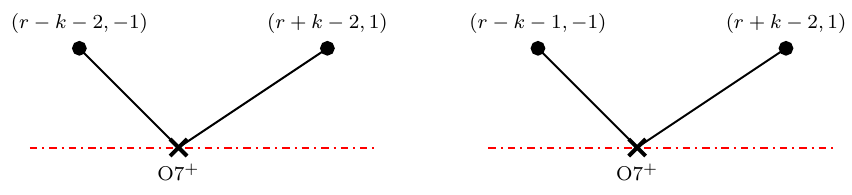
Figure 1 . Brane webs for pure SO( N ) gauge theory at the infinite gauge coupling limit for the case where N = 2 r (left) and N = 2 r + 1